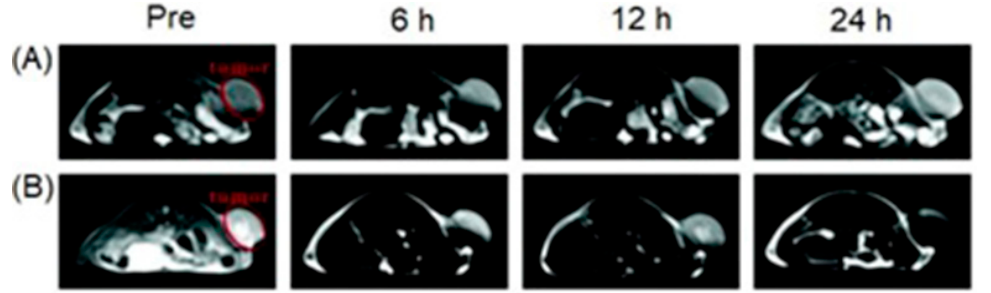
Figure 61. ( A ) T 1 - and ( B ) T 2 -weighted MRI images of a 4T1 tumor-bearing mouse. MRI images were acquired before and 6, 12, and 24 h after injection of the nanocomposites (10 mg kg –1 ). Solutions of nanocomposites were injected into the mouse through tail vein at different times. Red circles high- light the tumor site. Adapted with permission of the Royal Society of Chemistry, from Albumin/sul- fonamide stabilized iron porphyrin metal organic framework nanocomposites: targeting tumor hy- poxia by carbonic anhydrase IX inhibition and T 1 – T 2 dual mode MRI guided photodynamic/photo- thermal therapy. Zhu, W.; Liu, Y.; Yang, Z.; Zhang, L.; Xiao, L.; Liu, P.; Wang, J.; Yi, C.; Xu, Z.; Ren, J. 6 , 2, 2018 ; permission conveyed through Copyright Clearance Center, Inc. [378].